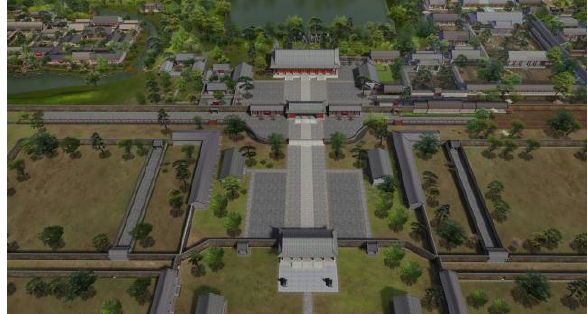
Figure 5. Restoration plan of Yuanmingyuan palace gate